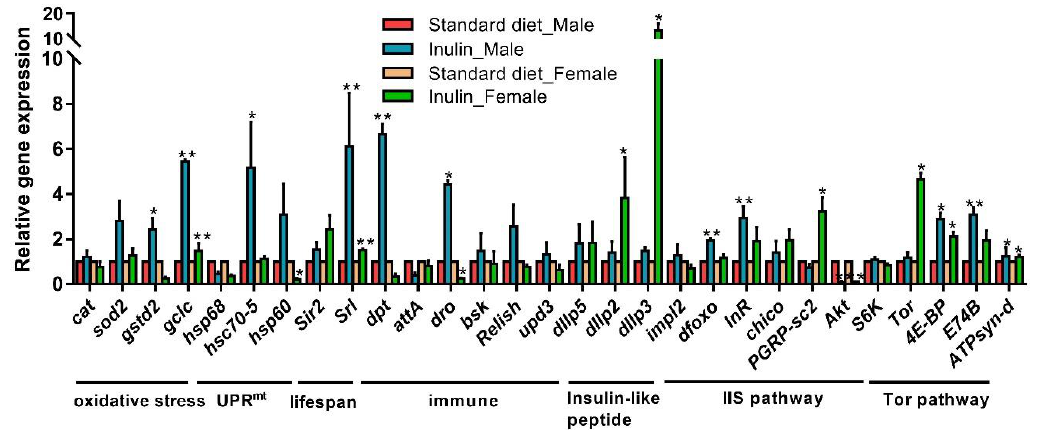
Figure 4. Effect of inulin on the relative transcript levels of metabolism-, stress-, immune-, and longevity-associated genes. * p ≤ 0.05; ** p <